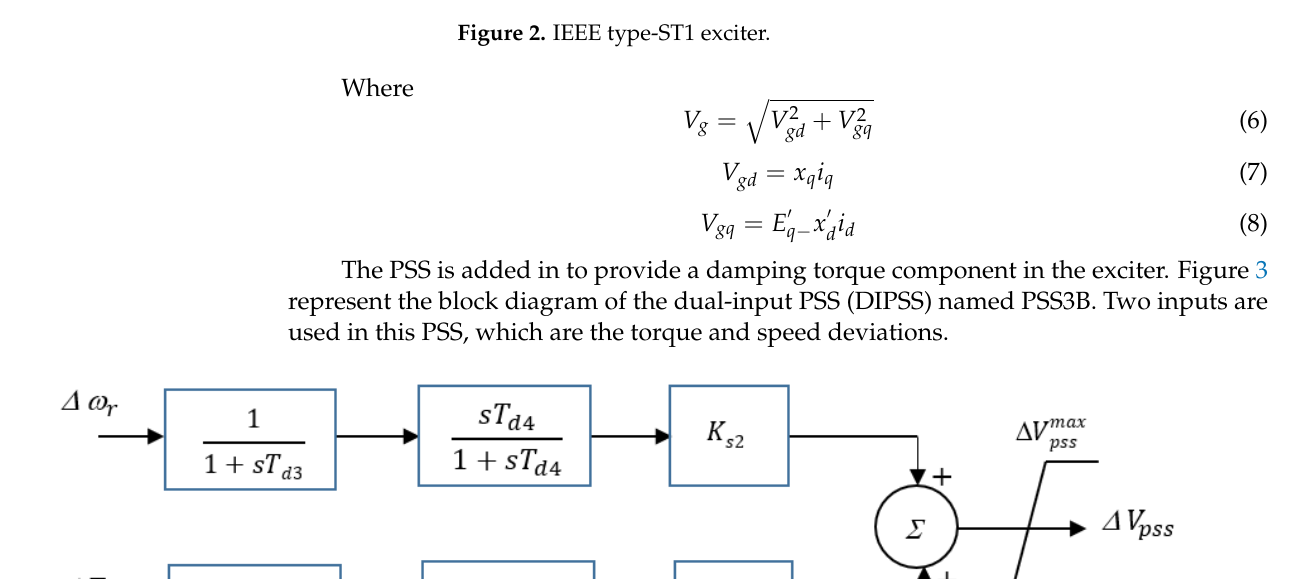
Figure 2. IEEE type-ST1 exciter.